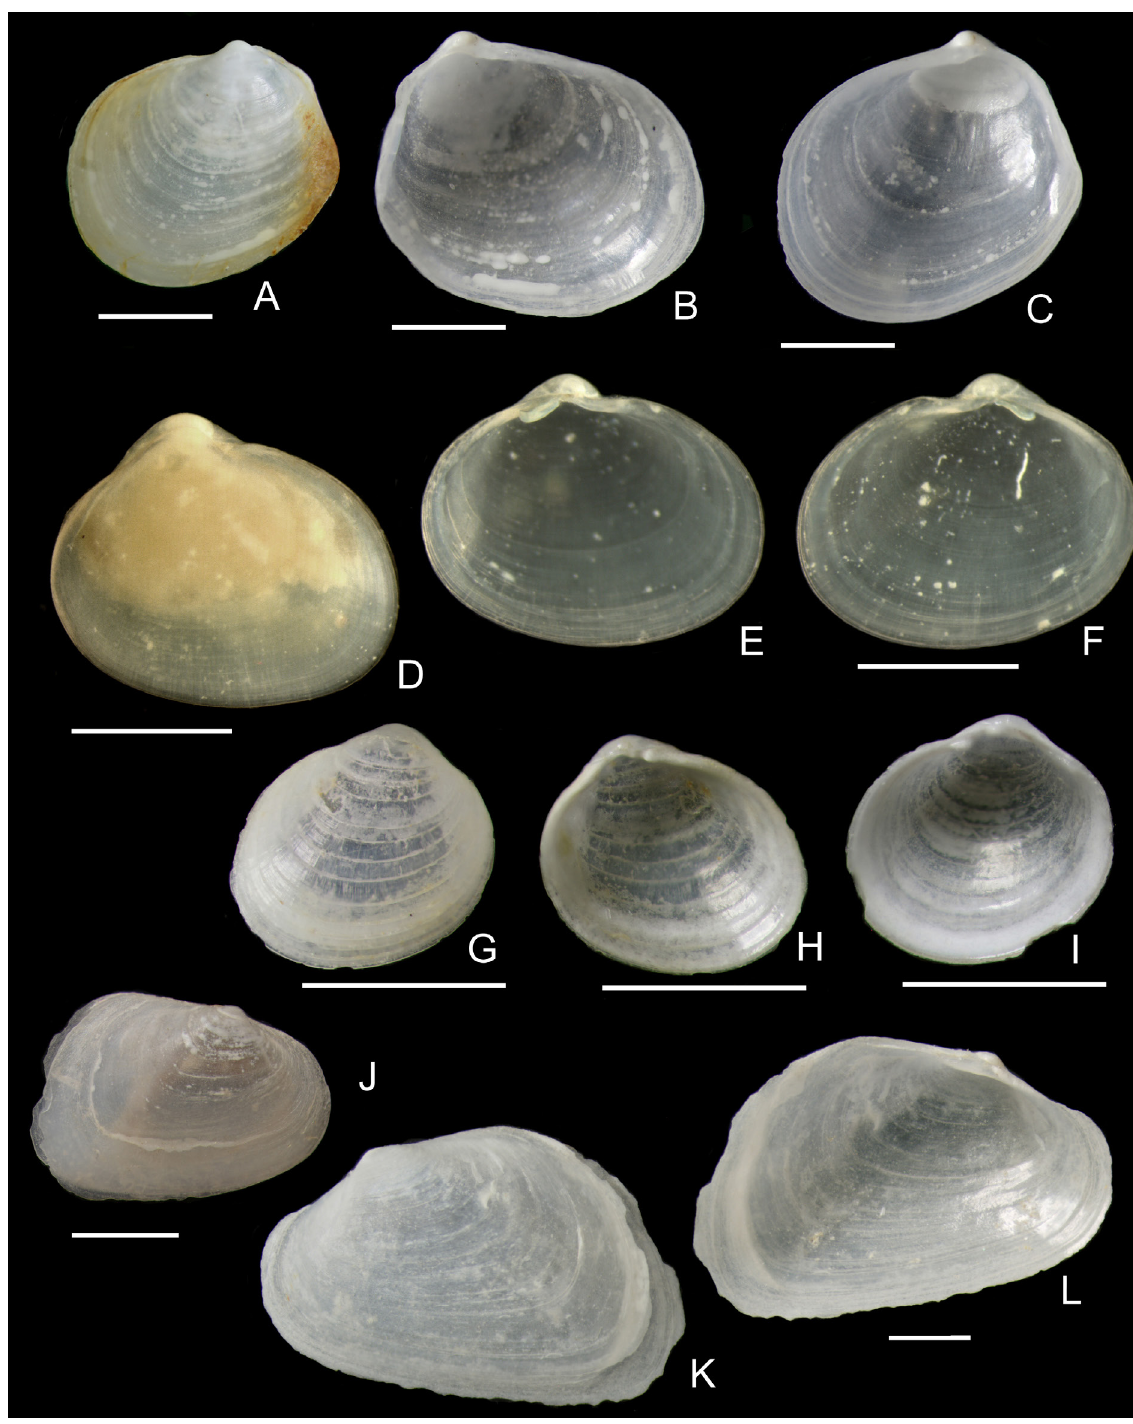
Fig. 38. Thyasiridae, Lasaeidae, Basterotiidae. A–C . Thyasira succisa (Jeffreys, 1876), SEAMOUNT 1, DW108, 1110–1125 m, 2.4, 2.9 and 2.7 mm. D–F . Syssitomya pourtalesiana Oliver, 2012, BANGAL 0711, V5, 1631 m, 2.2 mm. G–I . Draculamya porobranchiata Oliver & Lützen, 2011, BANGAL 0711, V4, 744 m, 1.3 mm. J–L . Atopomya dolobrata Oliver, 2013, SEAMOUNT 1, DW116, 985–1000 m, 2.8 and 5.2 mm. Scale bars = 1